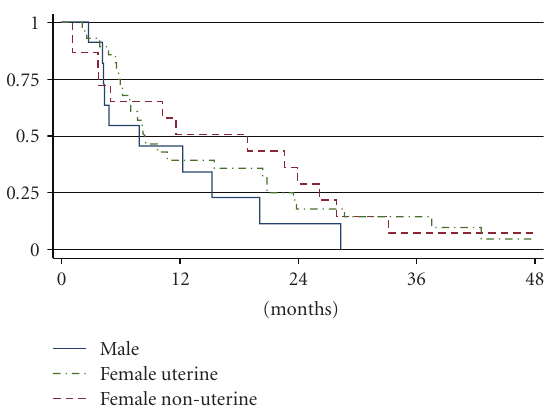
Figure 2: Overall survival according to gender and site of